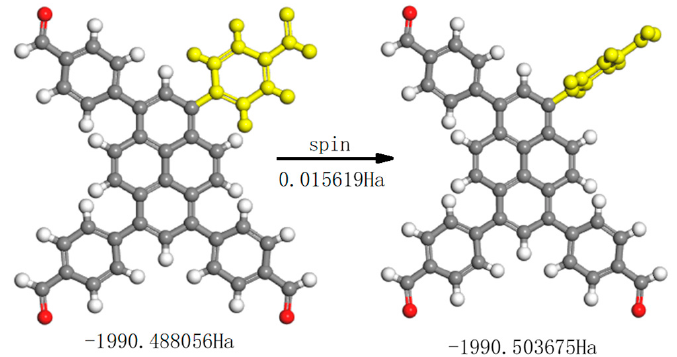
Figure 12. The benzene ring spin energy of TFFPy.